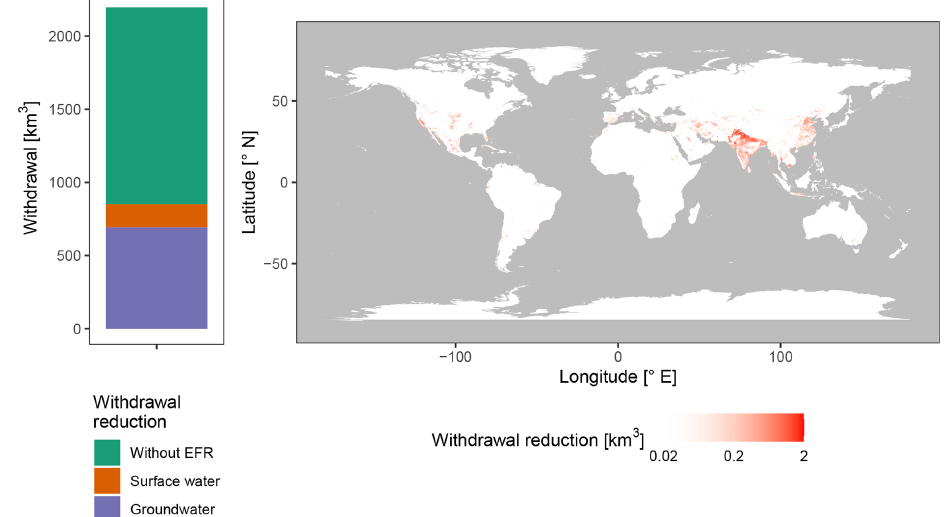
Figure 9. Average annual irrigation water withdrawal reductions when adhering to EFRs as a global gross total (a) and as spatially distributed values (b) . Global gross totals are separated into withdrawals without any reduction (green), surface water withdrawal reductions (orange), and groundwater withdrawal reductions (purple). Note the log axis for the spatially distributed withdrawal reductions to better display the spatial distribution of the